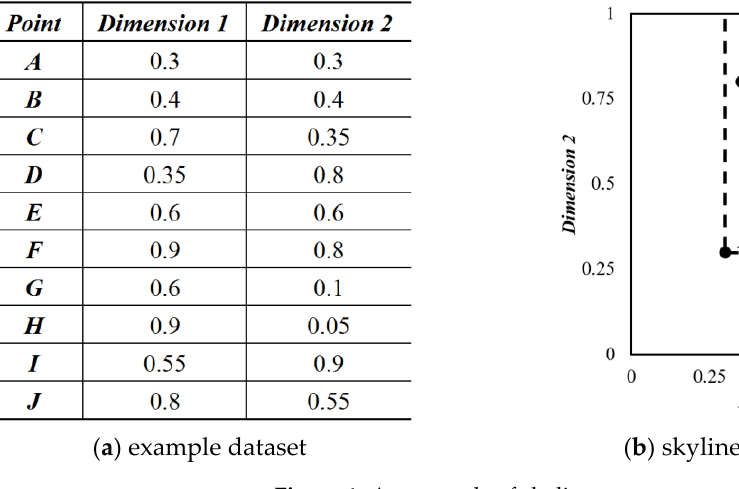
Figure 1. An example of skyline query.